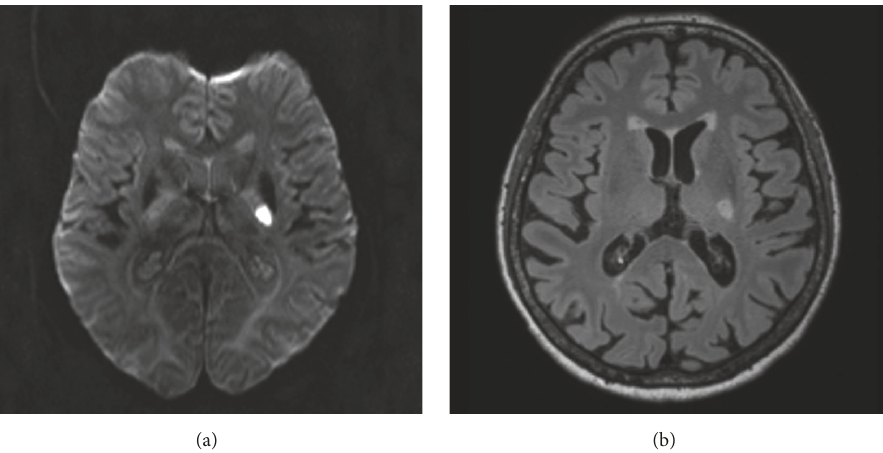
Figure 1: (a) Axial imaging showing diffusion restriction with a corresponding reduction in signal ADC map (not shown in figure). (b) Axial flair imaging with hyperintense infarction areal in the capsule leg on the left posterior internal